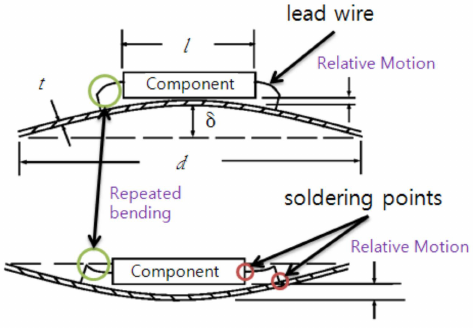
Figure 10. Relative bending motion between components and